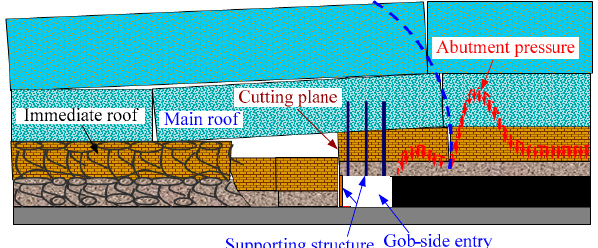
Figure 3. Structural model cross-section of non-pillar